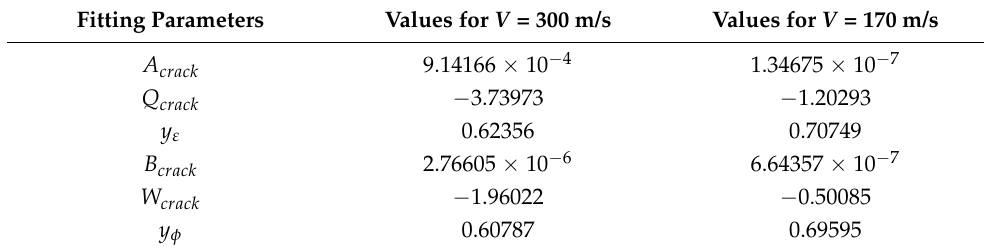
Table 4. Fitting parameters used in calculating kinetic energies.